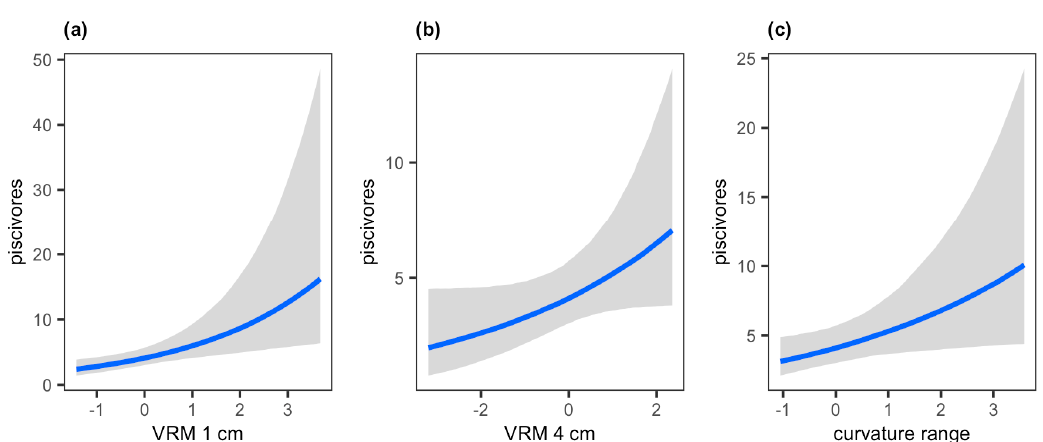
Figure 5. Conditional effect plots for ( a ) the standardized mean VRM at 1-cm deviation, ( b ) the standardized mean VRM deviation at 4-cm resolution and ( c ) the standardized curvature range showing the estimates of piscivore abundance per survey site.